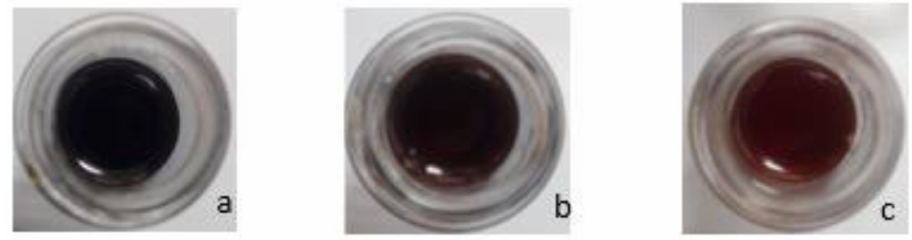
Figure 5. Appearances of ( a ) urushiol, ( b ) EU, and ( c ) AEU.